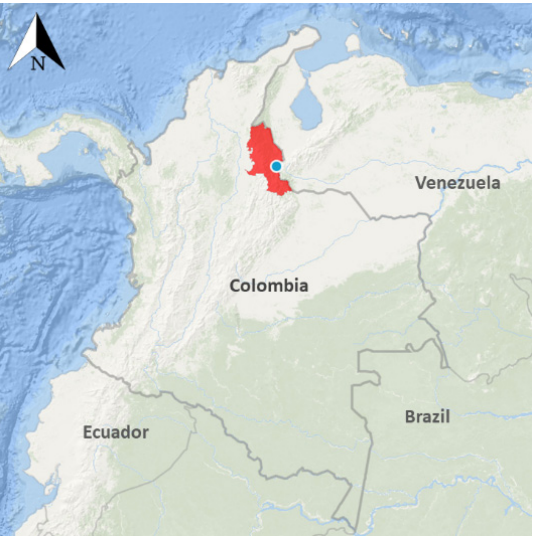
Figure 1. Map of the study site located the State of Norte de Santander,